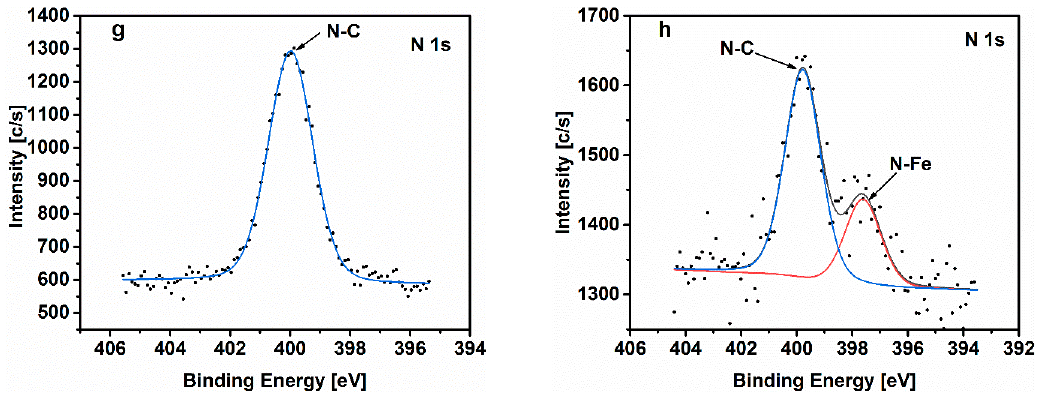
= 40 bar in the presence of 1.0 g L − 1 of GA at 25 °C: 2